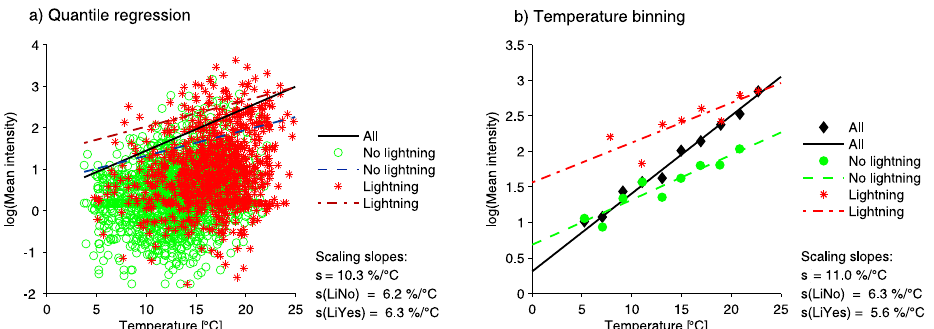
Figure 3. Example of the estimates of scaling slopes by (a) the quantile regression method and (b) the temperature binning method for the Wynau station. Slopes for no-lightning (green, s(LiNo)) and lightning (red, s(LiYes)) events as well as all events together (s) are shown and their magnitudes in % ◦ C − 1 are reported. This figure is reproduced for dew-point temperature in the